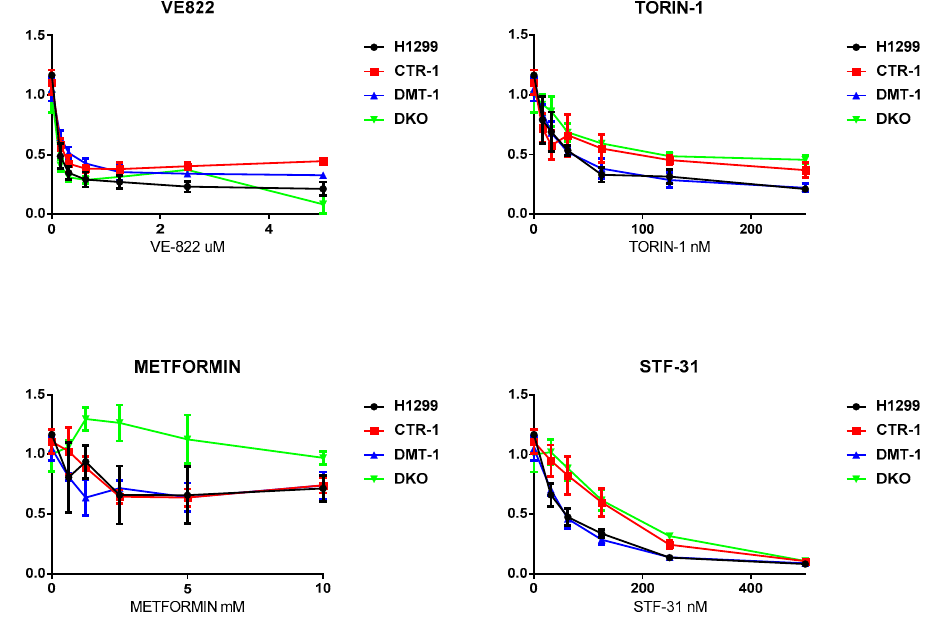
Figure 9. Cytotoxic activity of VE-822, Torin-1, Metformin, and STF-3 in H1299 parental cells and in KO derived. X-axis: drug concentration. Y-axis: growth rate. Growth inhibitory activity was determined using the MTS test. Each point represents the mean ± SD of six replicates.